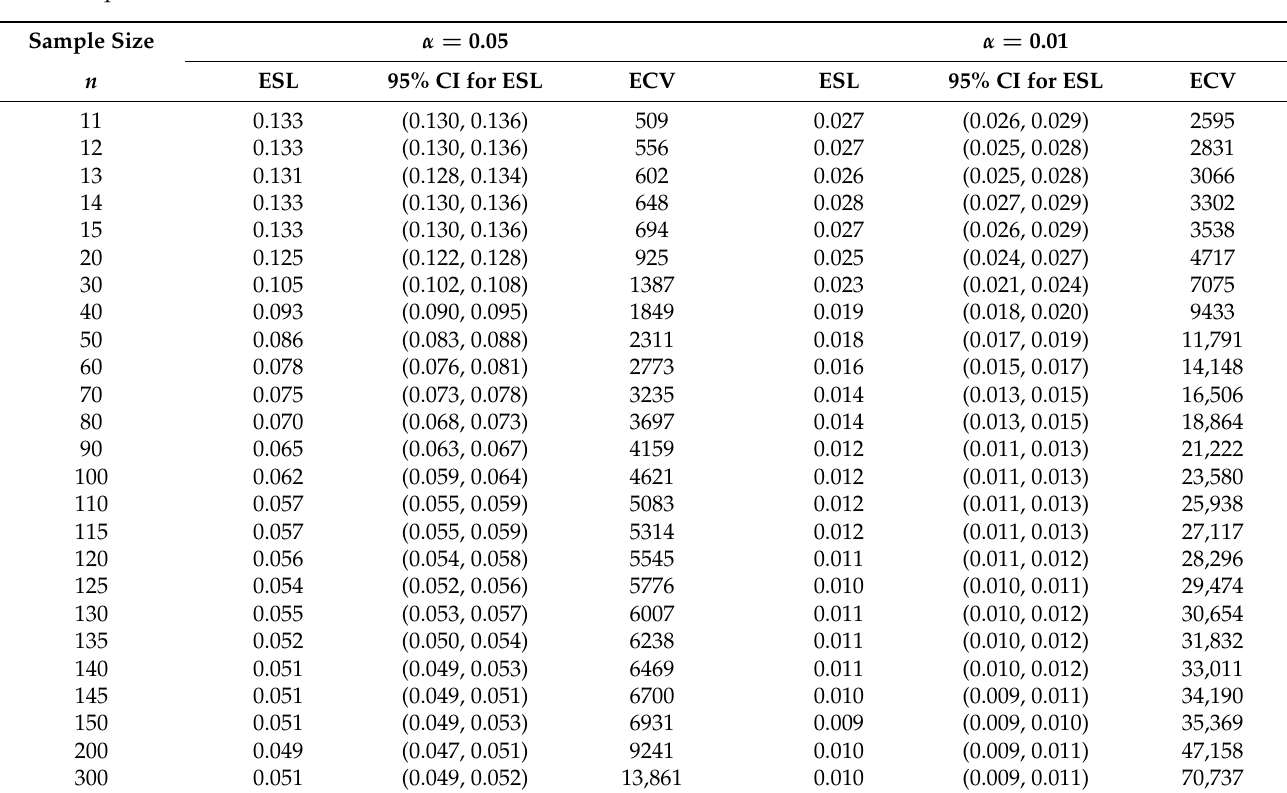
Table 4. ESLs with asymptotic 95% CIs of the supremum test statistic for various sample sizes when d = 10 and the NSLs are equal to 0.05 or